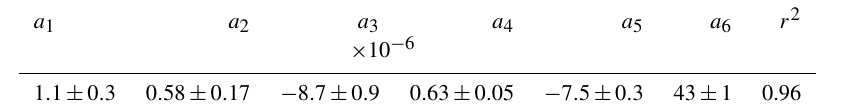
Table 6. The fitting parameters a 1 – a 6 and determination coefficients of Eq. (6) for j (O 1 D) in the ozone column range of 300–330DU.